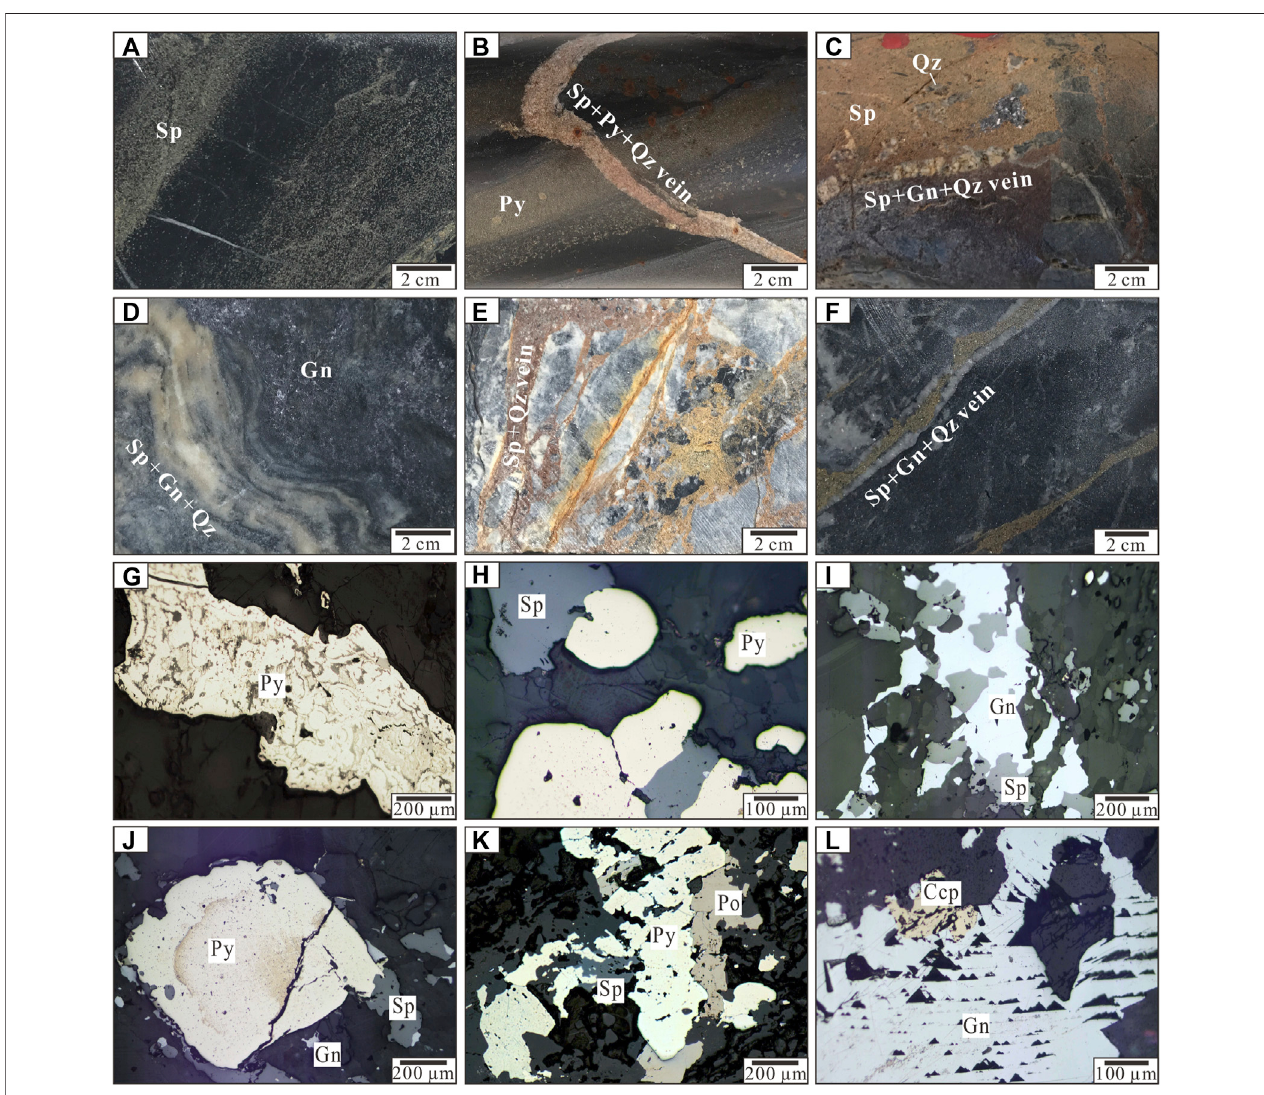
FIGURE 3 | Photographs of ore and mineral assemblages from the Haerdaban Pb-Zn deposit (A) Fine-grained sphalerite with laminated structure (stage 1) (B) Pyrite-sphalerite-quartzveins(stage3)crosscuttinglaminatedpyriteofstage1 (C) Sphalerite-galena-quartz veins(stage3)crosscuttinglaminatedsphaleriteandgalena ofstage1 (D) Sinuousquartz-sul fi deveins(stage2)crosscuttinglaminatedgalenaofstage1 (E – F) Sphalerite-galena-quartzveins(stage3) (G) Colloidalpyritecrystalsof stage 1 (H) Pyrite replaced by sphalerite (stage 1) (I) Galena replaced by sphalerite (stage 1) (J) Pyrite replaced by galena and sphalerite (stage 2) (K) Pyrrhotite replacedbypyritewhilepyritereplacedbysphalerite(stage3) (L) Chalcopyritereplacedbygalena(stage3).Abbreviations:Py(pyrite);Po(pyrrhotite);Ccp(chalcopyrite); Gn (galena); Sp (sphalerite).